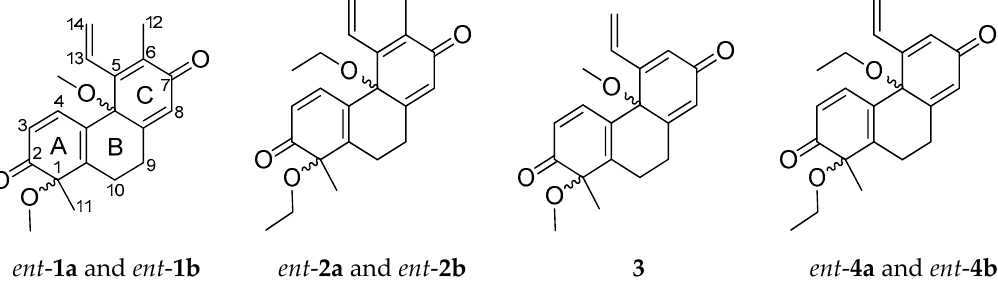
Scheme 1. Transformationofjuncusolandeffusolunderdifferentconditions. PIFA:[bis-(trifluoroacetoxy)]iodobenzene.